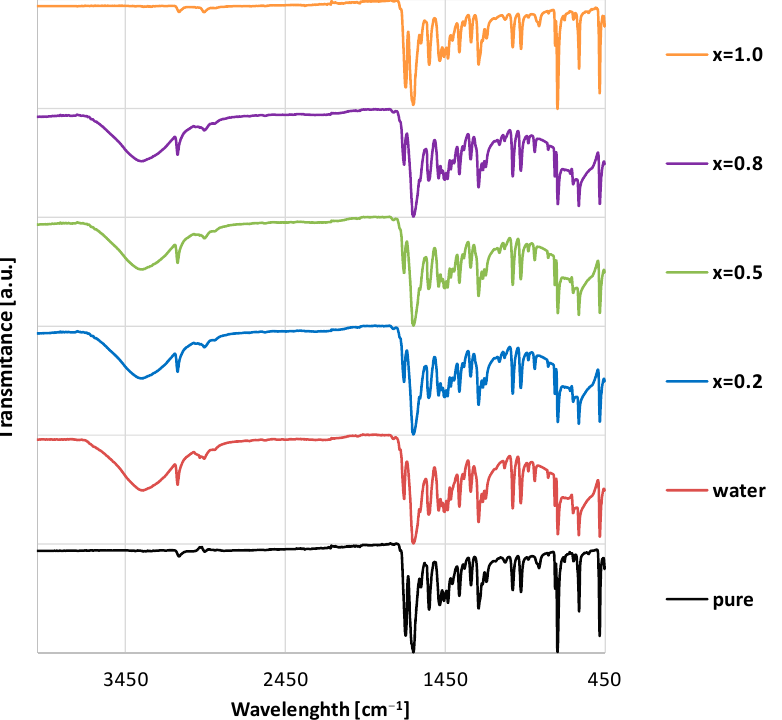
Figure 1. The FTIR spectra of caffeine precipitates after solubility measurements in NADES (choline chloride + glycerol), water and their mixtures. Values in parentheses indicate the mole fractions of ccNADES in solute-free solutions. For comparison, the spectrum of pure caffeine is presented.